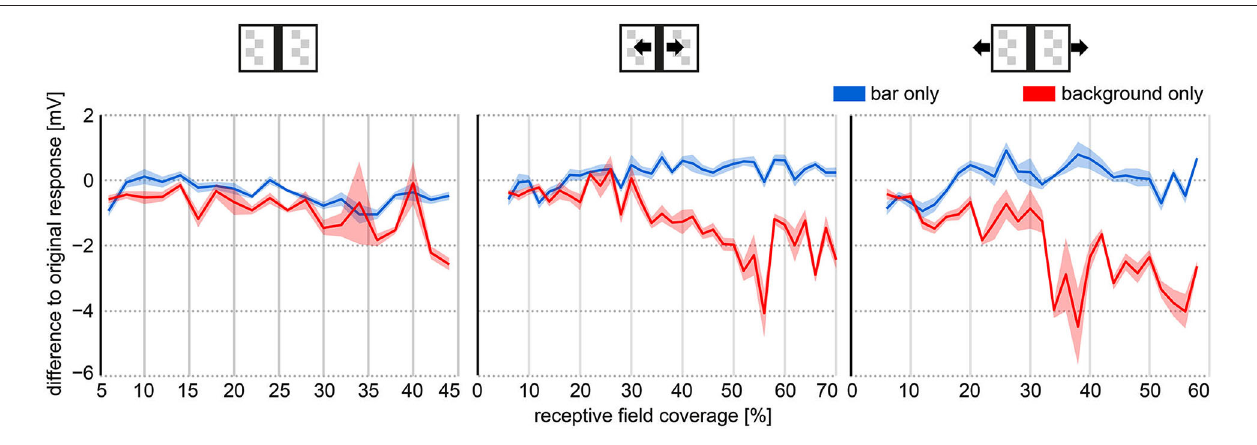
coverage was binned in 2 ◦ bins. The response differences were averaged within these bins. Receptive fields of HSE cells were roughly approximated to range from 20 ◦ contralaterally to 172 ◦ ipsilaterally in azimuth. Right and left HSE responses were pooled. Thick lines represent average response difference, shaded areas represent the